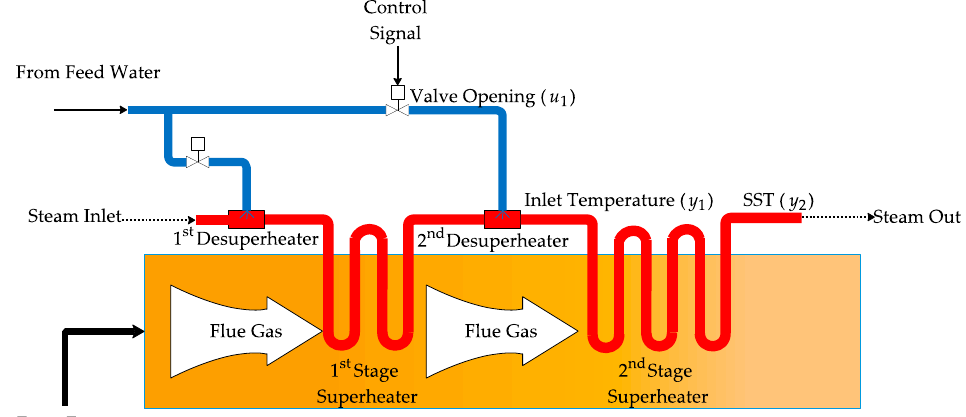
Figure 1. The schematic diagram of SST system in a power plant.